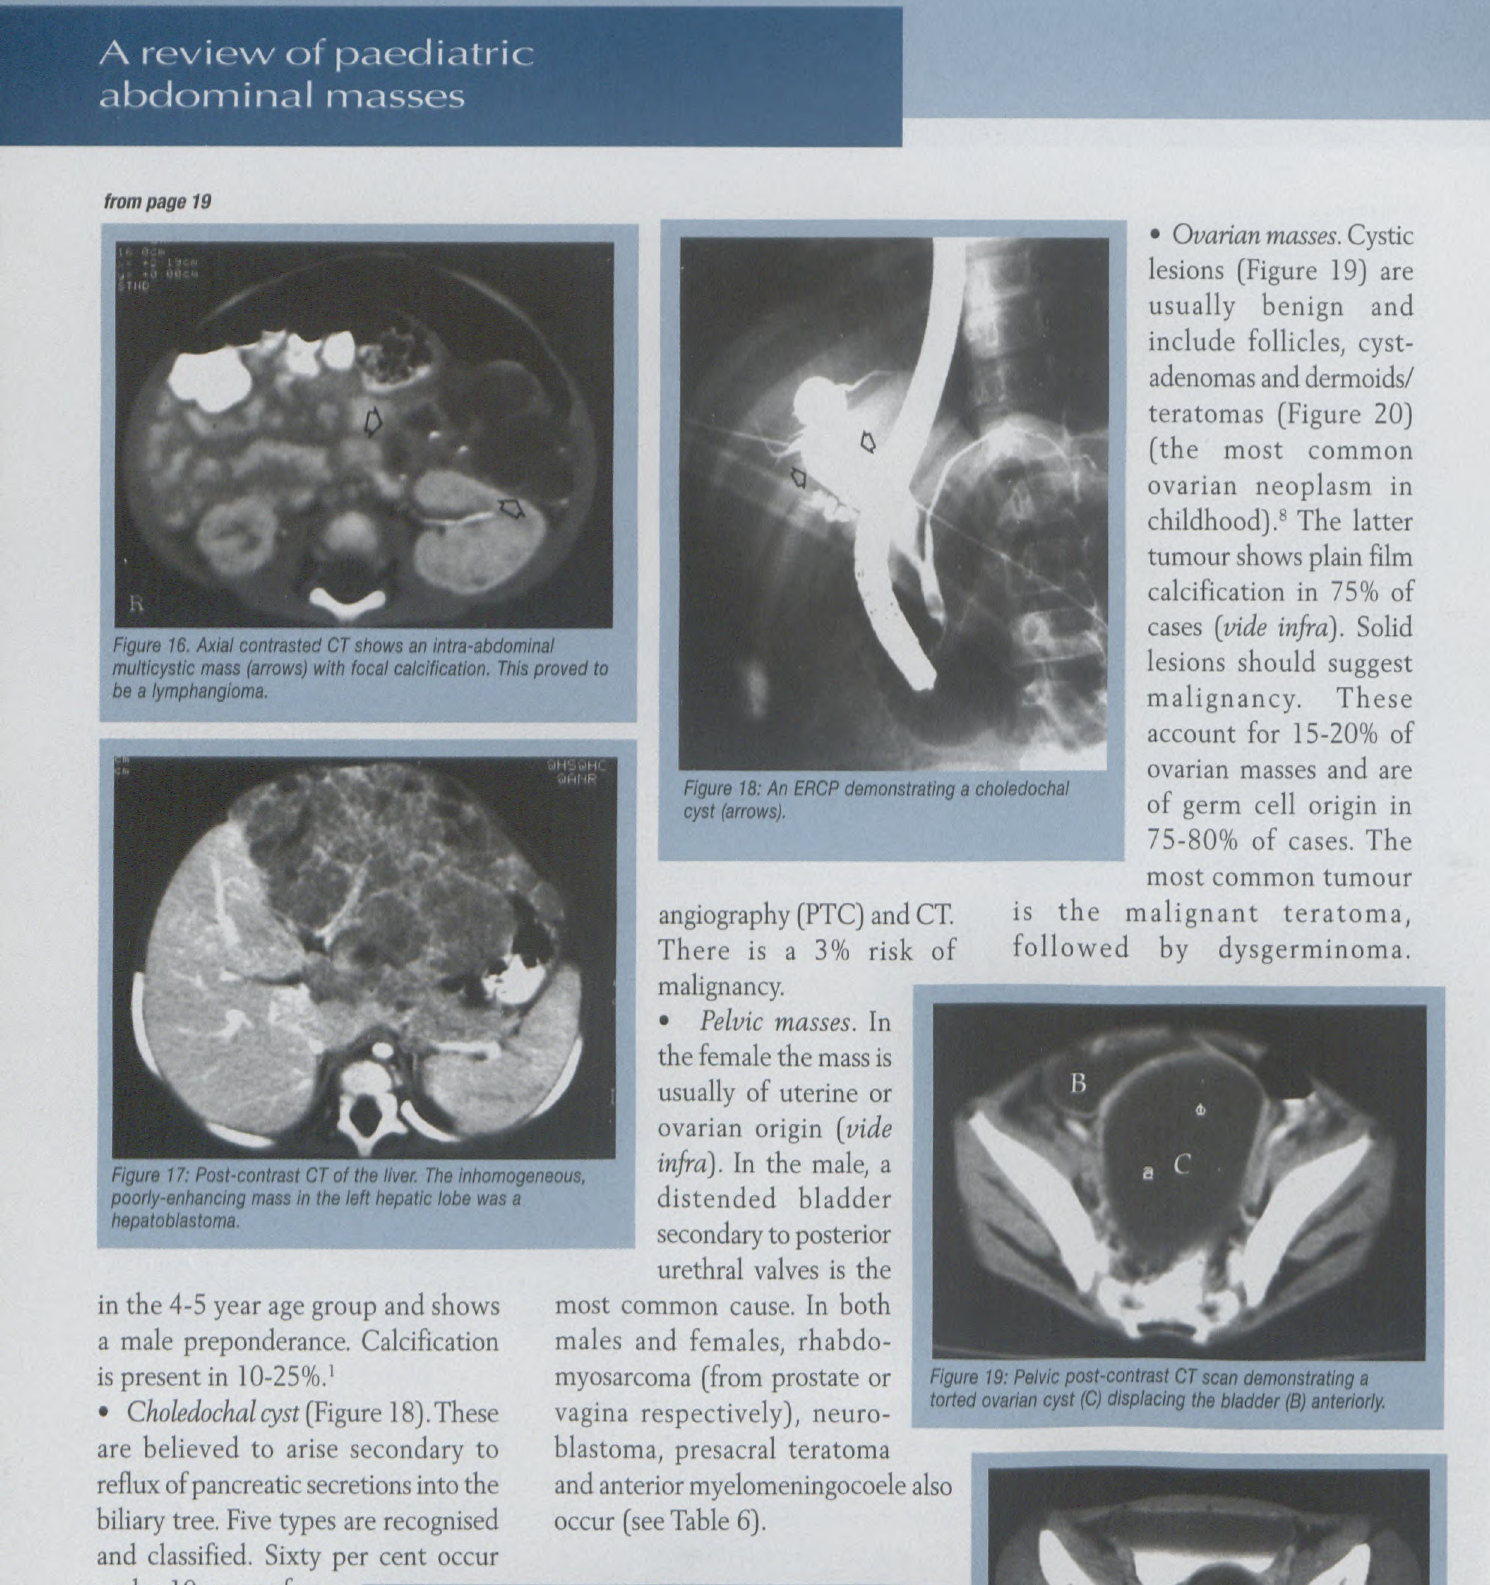
Table 6: Most common causes for